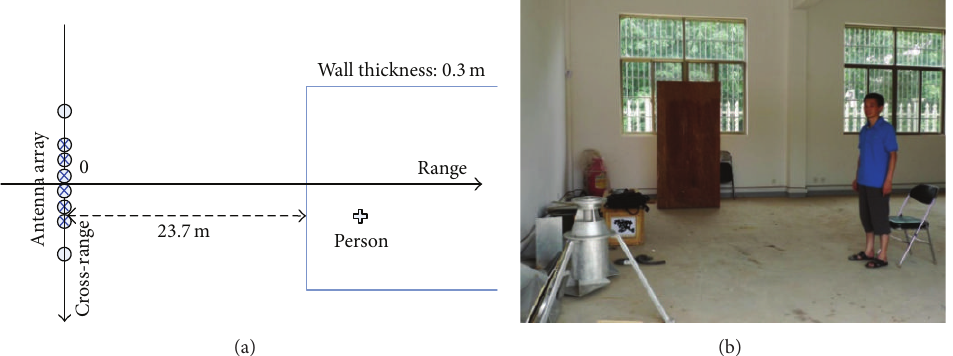
Figure 17: Imaging of a person inside a building: (a) the geometry of the imaging and (b) a man stands behind the left-side cinderblock